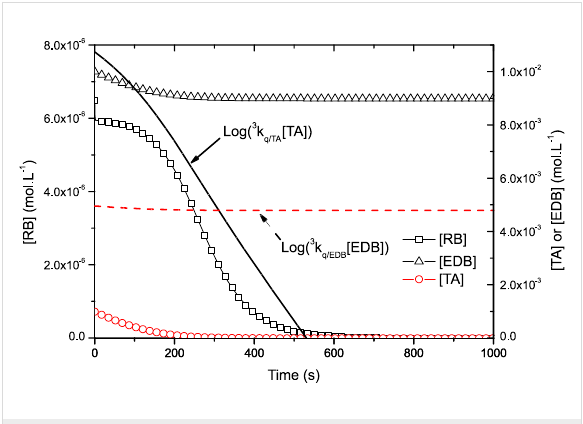
Figure 5: Evolution of RB, TA and EDB concentrations in the photo- cyclic system. The logarithm of oxidative and reductive pseudo first order reaction rates are given in plain and dashed lines,